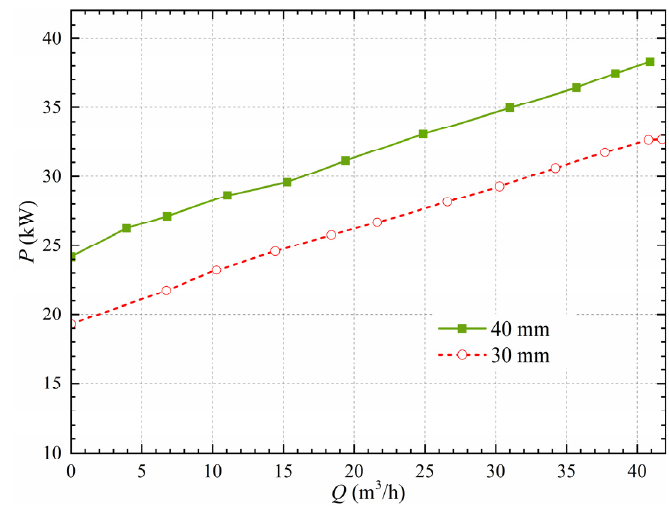
Figure 22. Comparison of unit power.